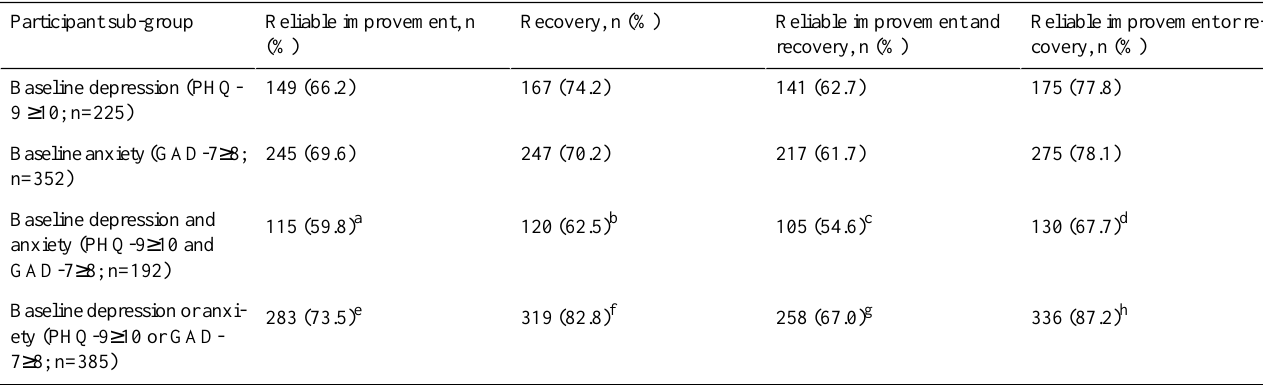
Reliable improvement or